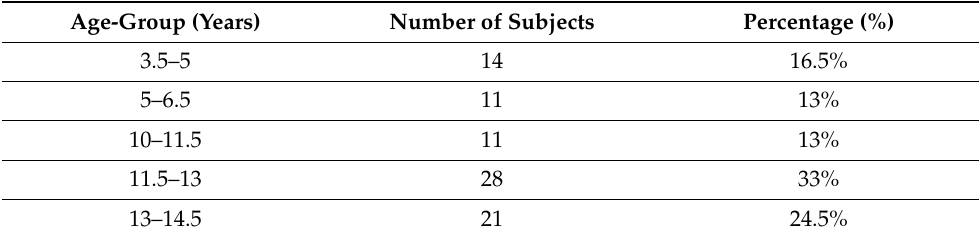
Table 1. Age-groups distribution of the study